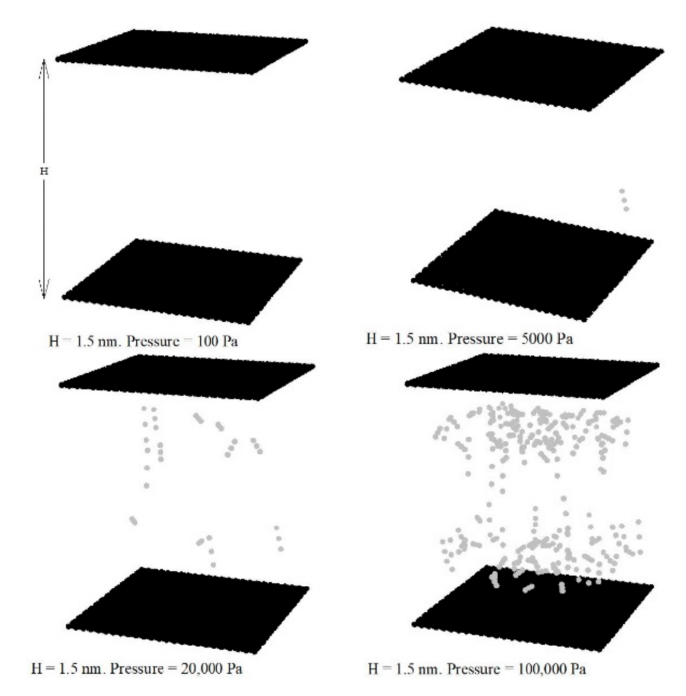
Figure 9. Snapshots of carbon dioxide adsorption at 273 K in pores of width 1.5 nm without the presence of NaOH molecules for various pressures, 100, 5000, 20,000, and 100,000 Pa (gray spheres represents carbon dioxide